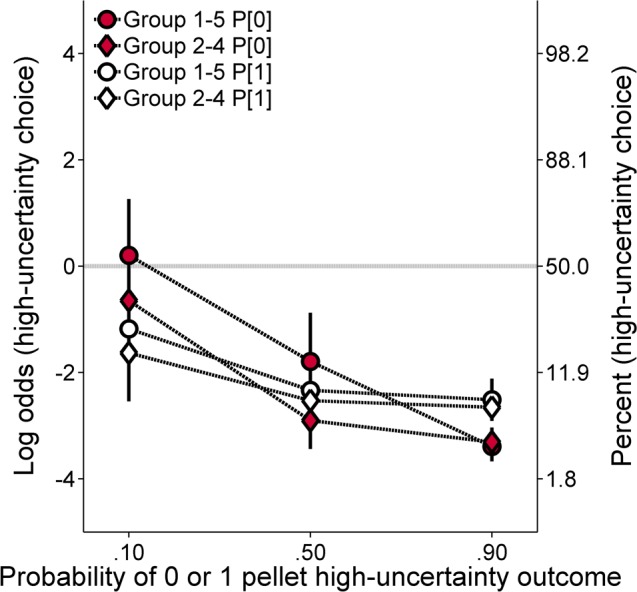
Mean (±SEM) log odds of high-uncertainty choices for each group in the high-uncertainty probability training procedure of Experiment 3A as a function of the probability of the 0-pellet outcome (P[0]) or the 1-pellet outcome (P[1]).Note that high-uncertainty choices are plotted against the probability of the manipulated outcome rather than as a function of overall probability of food, as was the case in previous figures. A second ordinate showing percentages corresponding to the log odds values was included to aid interpretation.